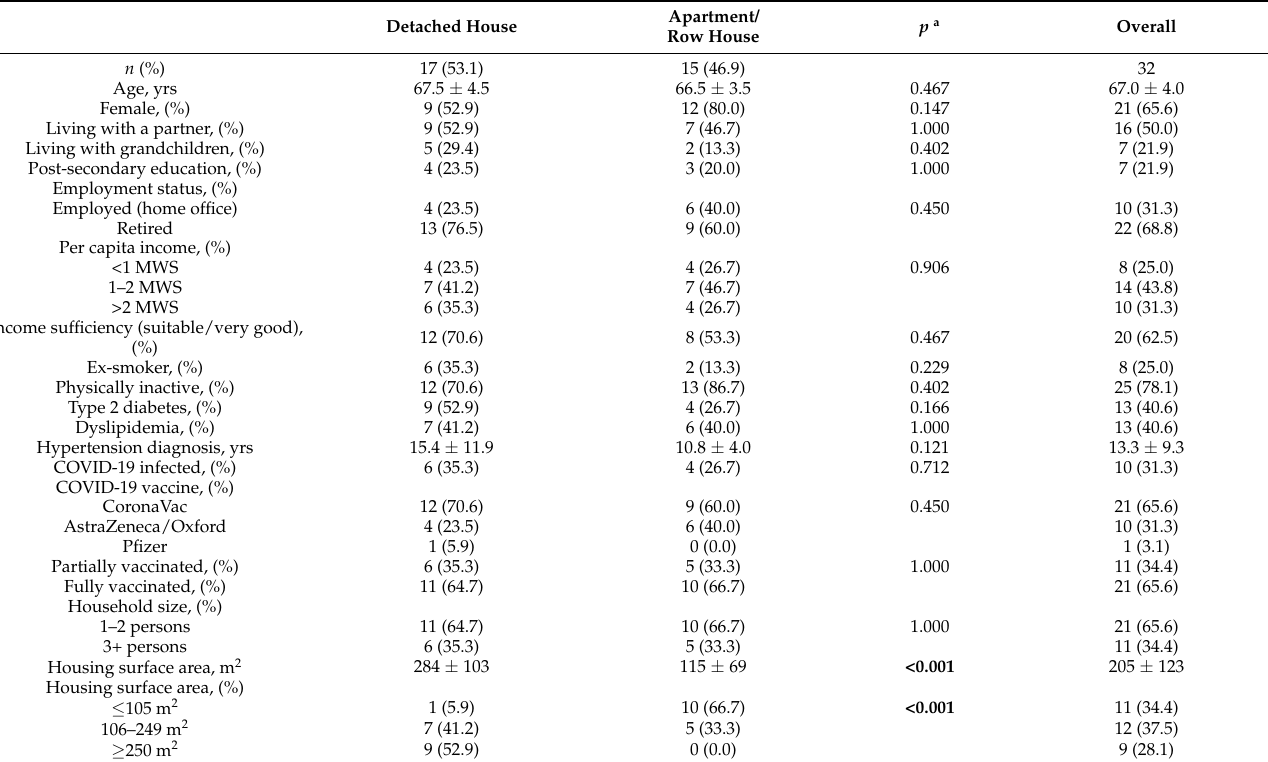
Table 1. Characteristics of the participants according to the housing type. Detached House Apartment/ Row House p a